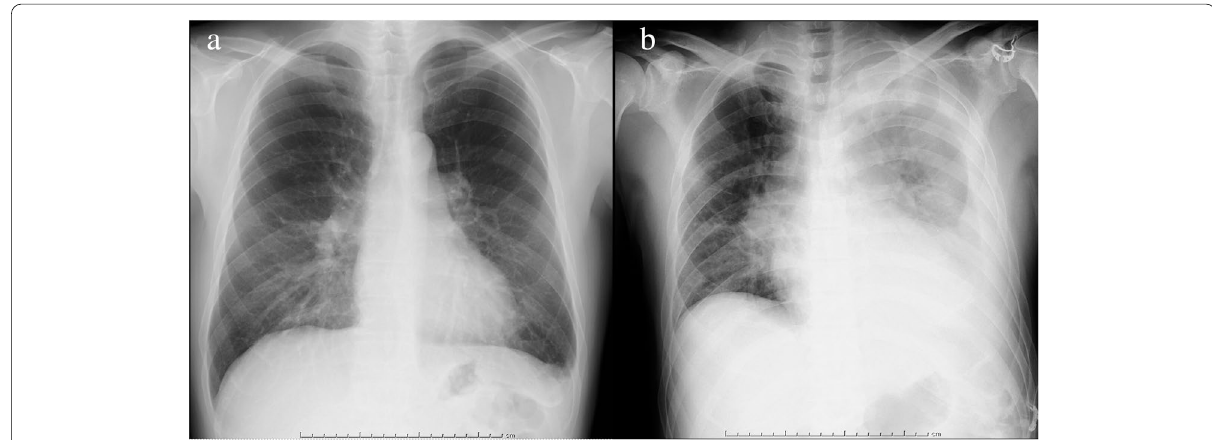
Fig. 1 a Chest radiograph image taken 27 days before surgery, showing a small left pleural effusion. b Chest radiograph image taken immediately following surgery, showing a large volume of left pleural